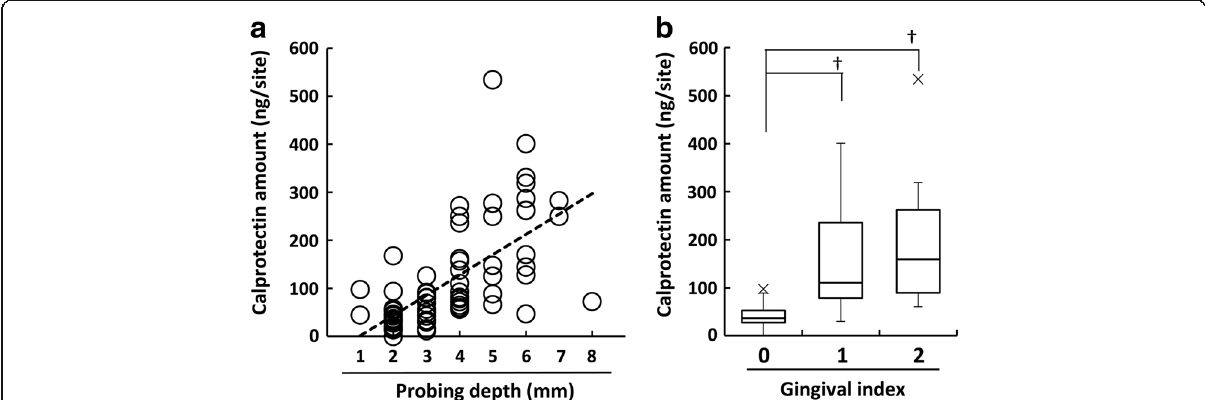
Fig. 3 Relationship between PICF calprotectin amounts and PD or GI scores. a The relationship between PICF calprotectin amounts and PD was evaluated in PICF samples from peri-implant disease and healthy groups ( n = 74, ρ = 0.709, P < 0.001). b Relationship between PICF calprotectin amounts and GI scores. Calprotectin amounts in PICF samples from sites with GI-0 ( n = 34), GI-1 ( n = 20), and GI-2 ( n = 20) were statistically analyzed. Horizontal bars show the median of each group. † P < 0.001